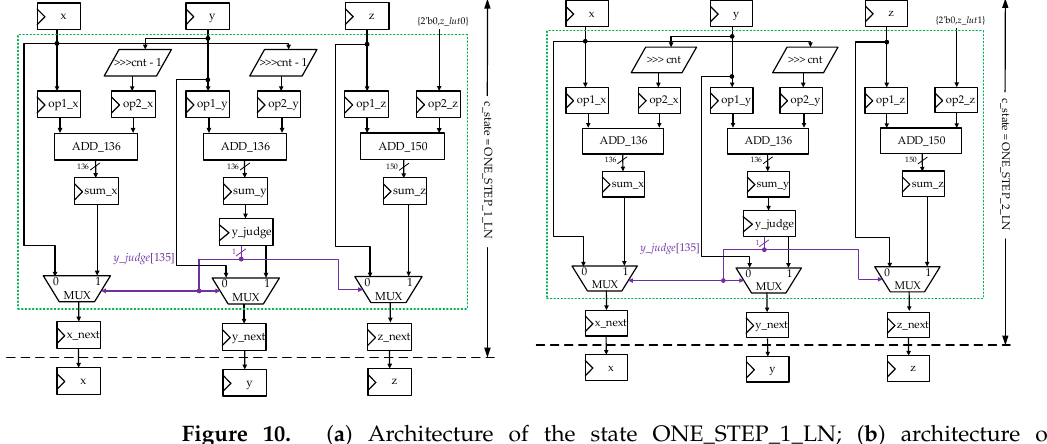
similar. Figure 9 takes { σ n , σ n + 1 , σ n + 2 , σ n + 3 } = {0, 0, 0, 0} as an example. Figure 10a,b demonstrate architectures of the state ONE_STEP_1_LN and state ONE_STEP_2_LN, respectively. The two green boxes in Figure 10a,b jointly make up the repetitive iterative x n + 4 , y n + 4 and z n + 4 data path for logarithmic functions. However, when register cnt is 5 or 41, the FSM jumps to state ONE_STEP_1_LN; when register cnt is 13 or